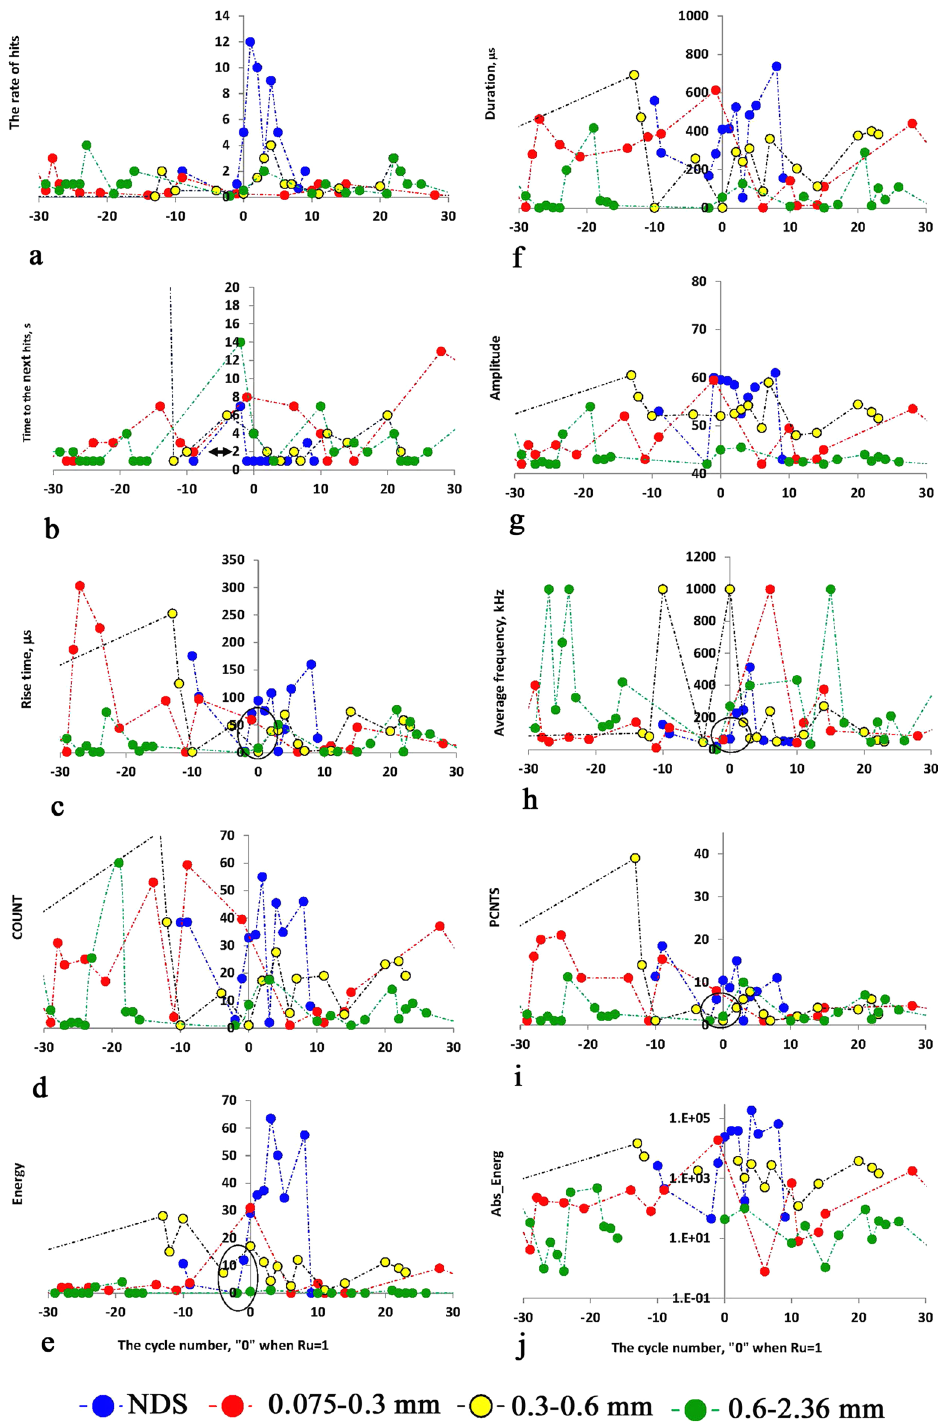
Figure 10. Ten AE parameters are as follows: ( a ) the rate of the number of AE signals (i.e., The Time between AE events per the Hit Number), ( b ) the time between the AE signals, ( c ) the change in the Rise-Time of AE signals, ( d ) the change in Counts, ( e ) the change in energy value, f. The change in signals’ duration, ( g ) the change in signals’ amplitude, h. The change in signals’ frequency, ( i ) the change in the number of peaks in AE signals, ( j ) the change in the value of absolute energy of AE signals, the X-values is the number of vibration cycles while 0 when the B factor value approaches the value equal to 1, the Y-axis is the value of corresponding AE number, the blue, green, yellow-black, and red circles are for dune sand, fractions 2.36–0.6, 0.6–0.3, 0.3–0.075 mm,